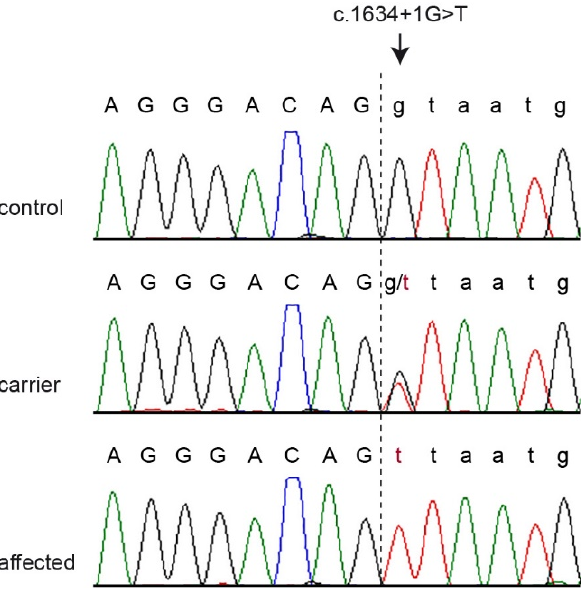
Figure 4. Representative Sanger electropherograms of a control, a carrier, and an affected dog illustrate the PRKG2 :c.1634+1G>T variant. The vertical dashed line indicates the exon/intron boundary.